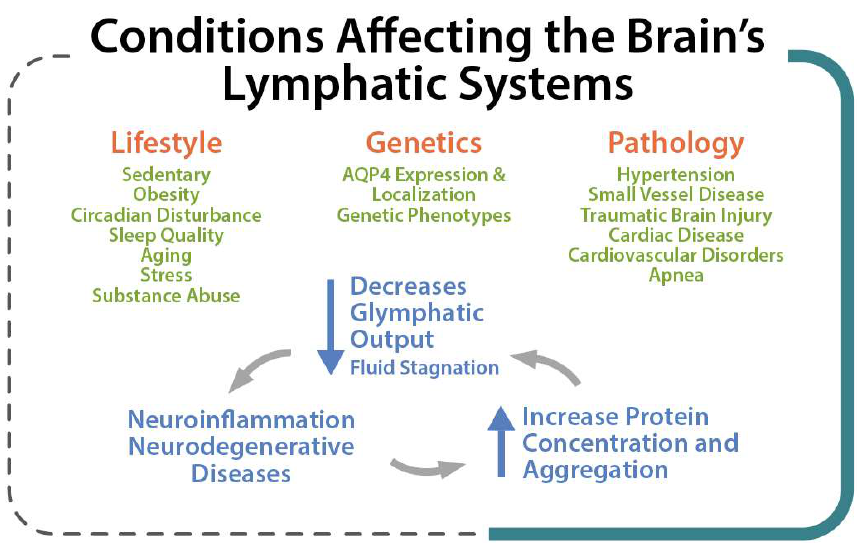
Figure 3. Lifestyle, Genetic and Pathological conditions that can strongly affect the brain lym- phatic systems. 2.2. MLVs, Olfactory/Cervical Lymphatic Drainage Route, and Their Association with CSF Cir- culation